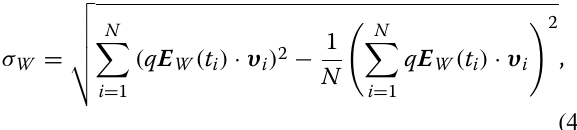
) and the ⊥ and N + − are the numbers of energetic electrons having positive and negative